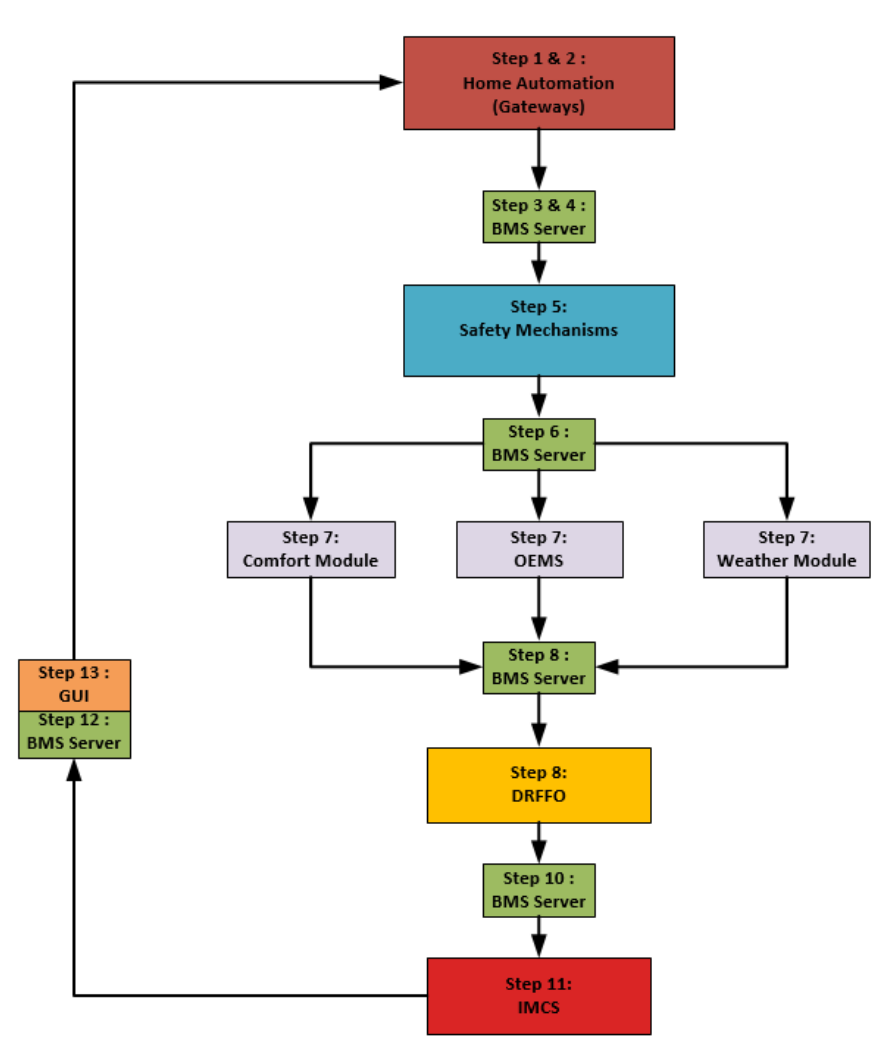
Figure 2. Sequence between the PnH ICT